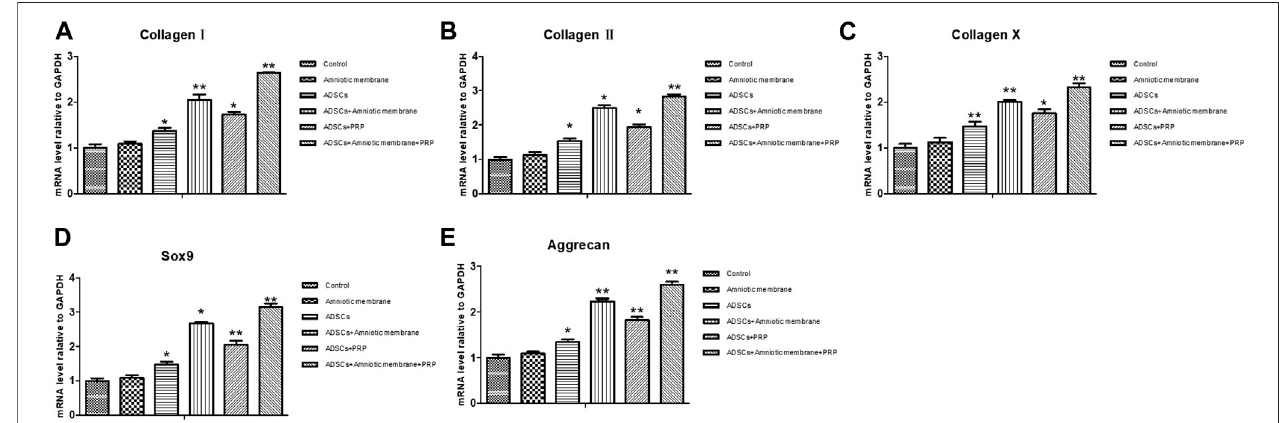
FIGURE7| Amniotic membrane+PRPgroupshowedthe highesttranscriptional levels ofCol I, ColII, Col X,Aggrecan, and SOX9genesintheextracellularmatrix of cartilage. ( A – E) RT-PCR was used to detect the mRNA expression of (A) collagen I, (B) collagen II, (C) collagen X, (D) Sox-9, and (E) aggrecan. The sequence of mRNA expression levels of these genes from high to low is as follows: ADSC + amniotic membrane + PRP group > ADSC + amniotic membrane group > PRP + ADSC group > ADSC > amniotic membrane and control group. Six groups were included for the analysis, including the control group, ADSC alone, amniotic membrane alone, ADSC + amniotic membrane, ADSCs + PRP scaffolds, and ADSCs + amniotic membrane + PRP. Five rabbits were included for every group and the extracellular matrix of cartilage was isolated, respectively.